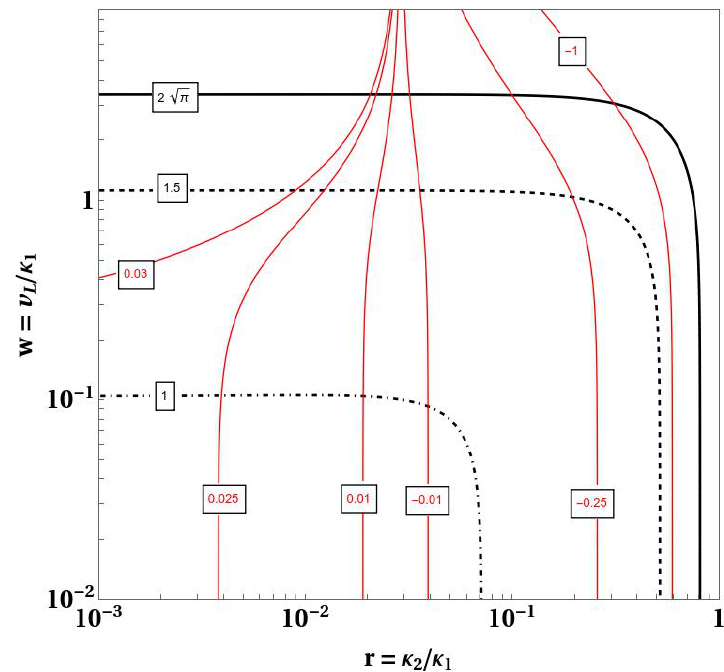
Figure 1. The black and red contours represent the values of y 33 and ˜ y 33